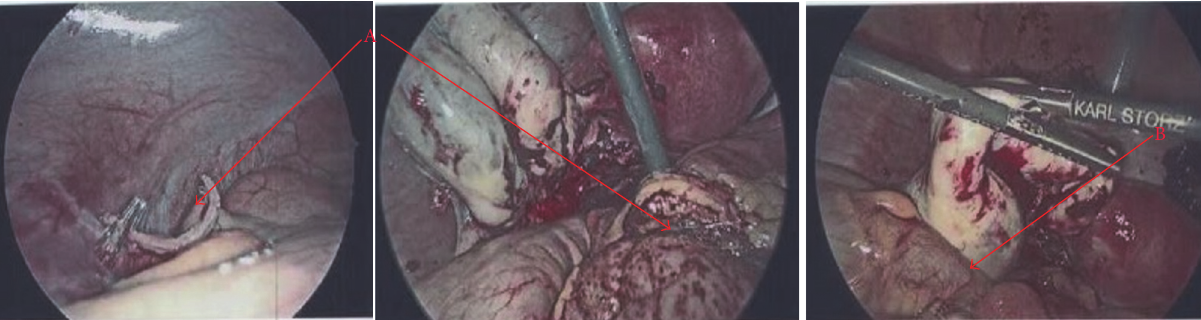
Figure 3: Intraoperative images. A: inflamed appendix; B: ruptured endometrial